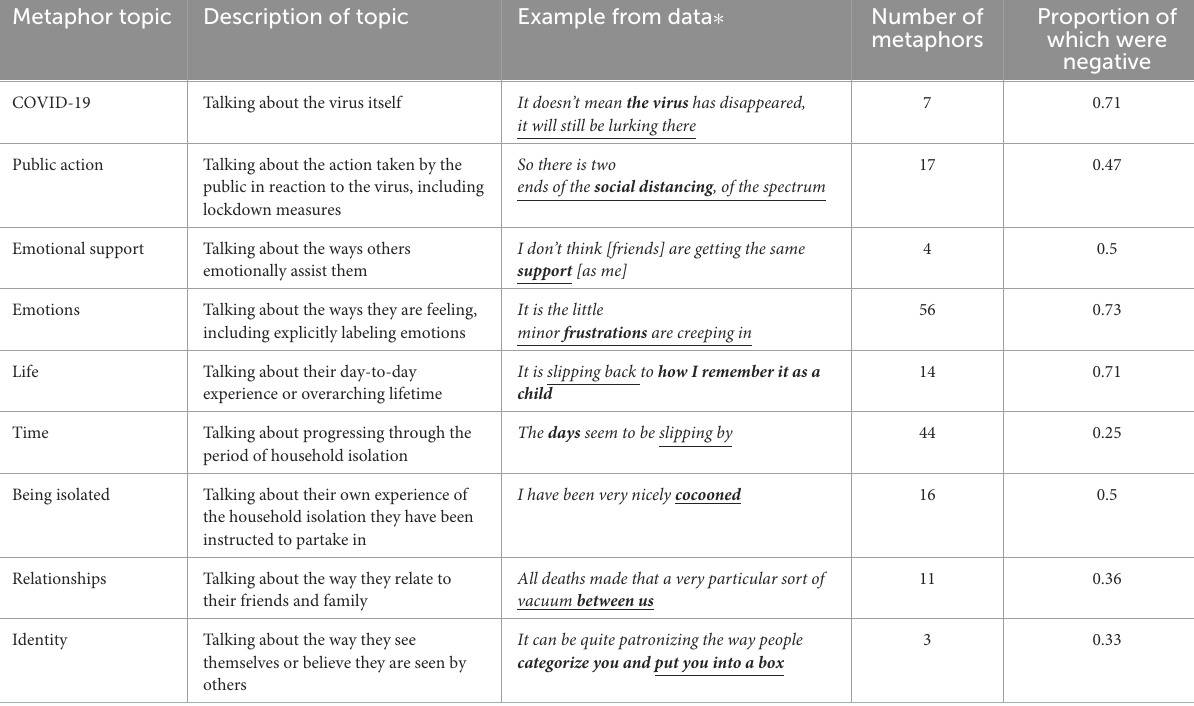
TABLE 1 Topics that were discussed using